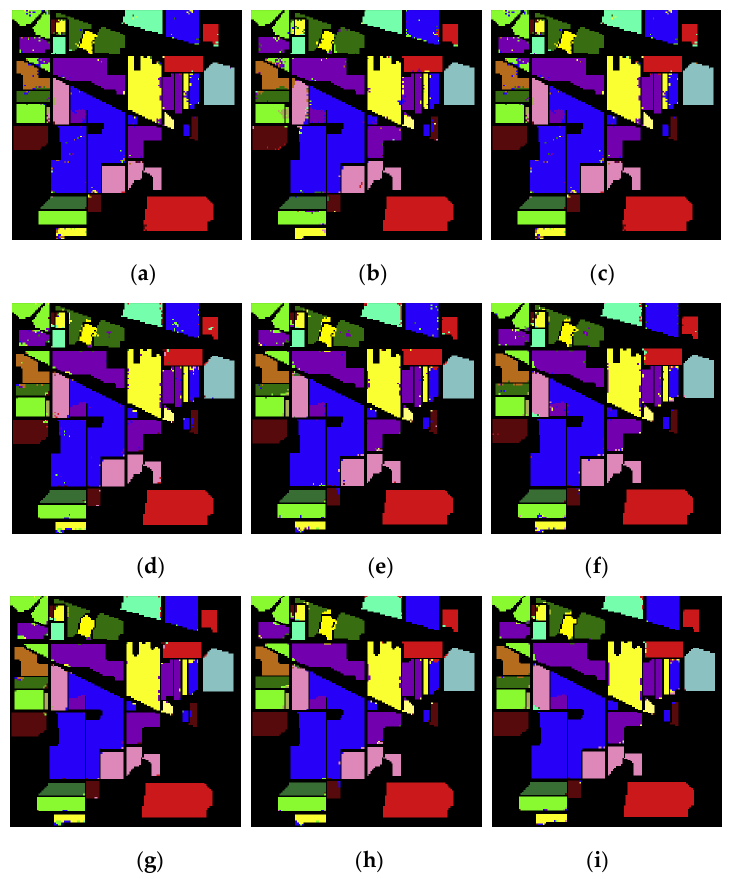
Figure 11. The classification results on Indian Pines dataset: ( a ) NDR; ( b ) IM; ( c ) IM_SPE; ( d ) NDR_MIG; ( e ) IM_MIG; ( f ) IM_SPE_MIG; ( g ) NDR_MIG_DN; ( h ) IM_MIG_DN; ( i ) IM_SPE_MIG_DN methods.